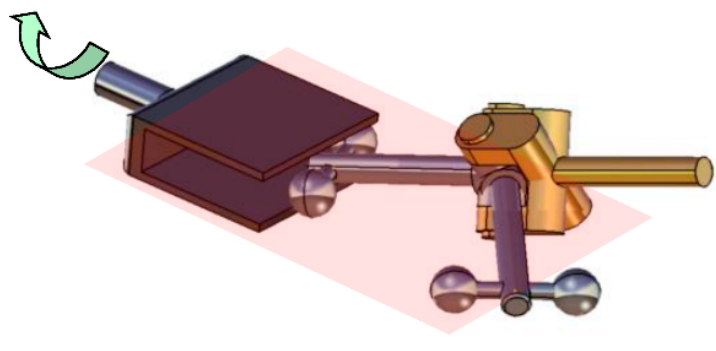
Figure 17. The two possible assembling poses of the mechanism. Based on Relation (42), the dependencies θ 2 ( θ 1 ) and also the angular velocity of the driven element were plotted, as seen in Figure 18. With the known dependency θ 2 ( θ 1 ) , one can represent θ 3 ( θ 1 ) , as in Figure 19. Using Relation (44), the trajectory of the center of frame 4 was traced with respect to the driving element, as in Figure 20. The angle of rotation and the angular velocity of the axis of centers in the symmetry plane of the channel were represented by applying Equation (48), as in Figure 21. The basculation angle of the intermediate element around the axis of centers is represented according to Relation (54) in Figure 22. From Figure 22, one can observe that the oscillations of the intermediate element around the axis of the centers of balls are identical for the two assembling possibilities. This apparent paradox is explained in a simple manner based on Figure 23, in which the angle ψ is the angle between the axis of rotation of the intermediate element and the plane of symmetry of the channel. Denoting with T the intersection point between the axes of rotation of the intermediate element from the two assembling situations, it can be noticed that the oscillation angle is the dihedral angle between the plane of symmetry of the channel, P, and the triangles TC (cid:48) 1 C (cid:48)(cid:48) and TC (cid:48) 2 C (cid:48)(cid:48) . The triangle TC (cid:48) 2 C (cid:48)(cid:48) can be obtained 2 2 1 by rotating the triangle TC (cid:48) 1 C (cid:48)(cid:48) around the normal TN, this motion preserves the angle ψ 1 and in consequence ψ 1 = ψ 2